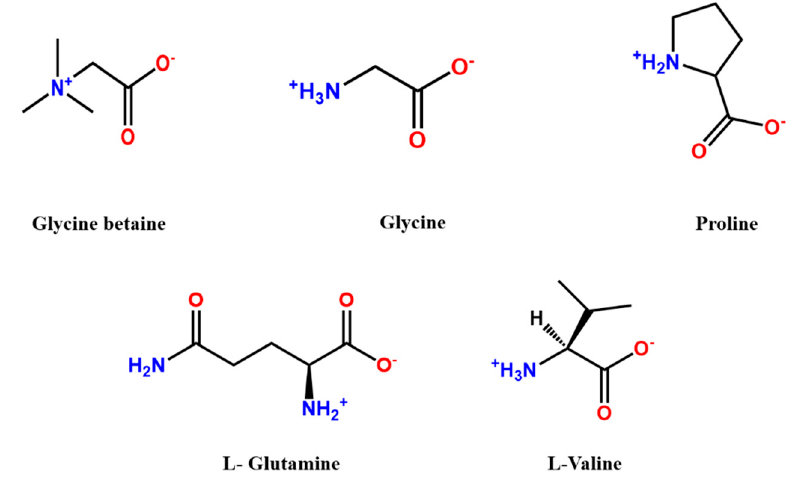
Figure 7. Chemical structures of some of the zwitterions used as draw solution in FO.